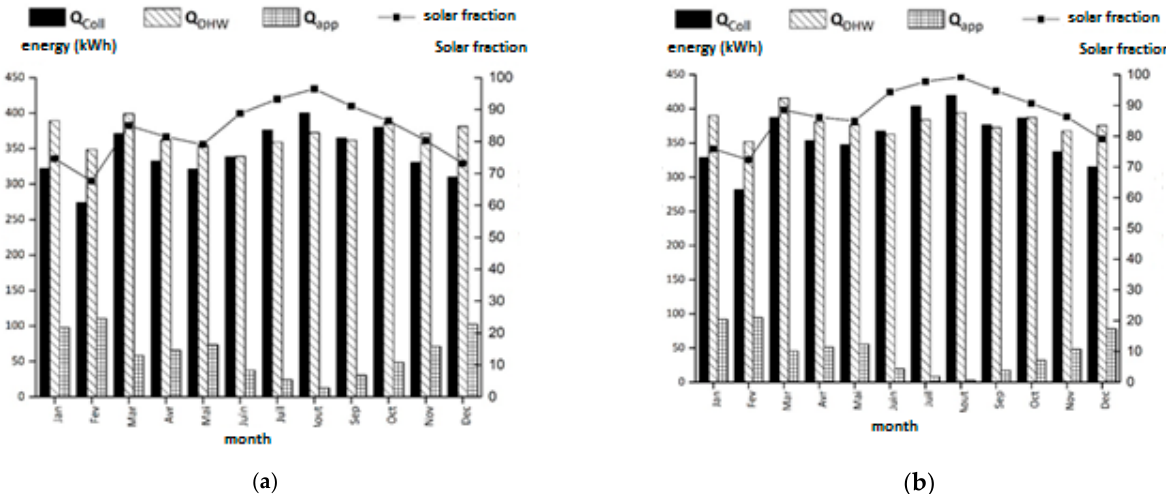
Figure 10. ( a ) Flat plate collector, ( b ) evacuated tube collector (high demand).